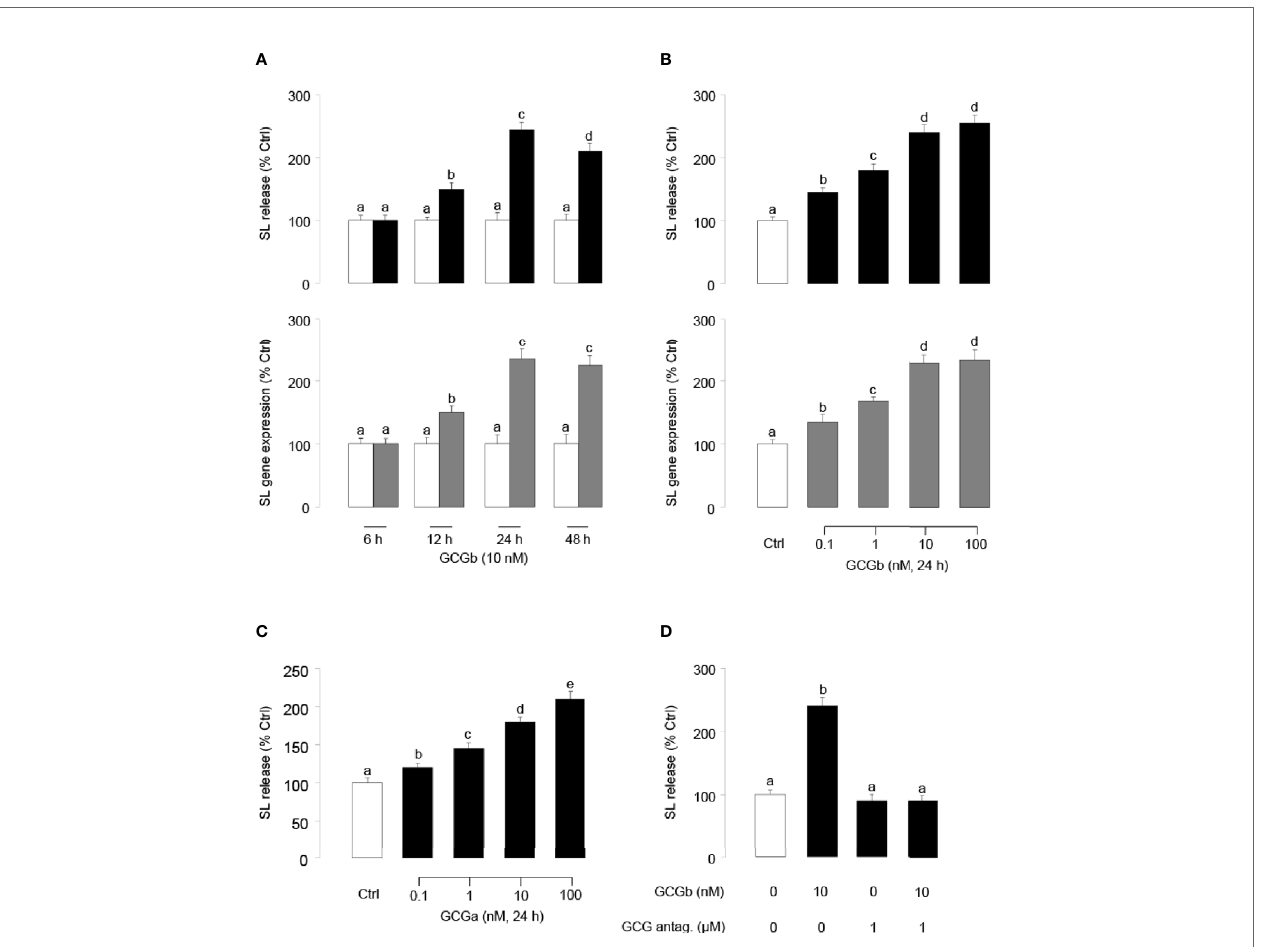
FIGURE 5 | Up-regulation of SL release and gene expression in tilapia NIL cells by GCGs. (A) Time course of tilapia GCGb treatment on SL release (upper panel) and mRNA expression (lower panel) in tilapia NIL cells. In these studies, NIL cells were incubated with GCGb (10 nM) for the duration as indicated. (B) Dose- dependence of GCGb treatment on SL release (upper panel) and mRNA expression (lower panel) in primary cultured tilapia NIL cells. NIL cells were routinely challenged for 24 h with increasing levels of GCGb (0.1 – 100 nM). (C) Parallel experiment using increasing doses of GCGa as the stimulant. NIL cells were routinely challenged for 24 h with increasing levels of GCGa (0.1 – 100 nM). (D) Effects of GCG antagonist on GCGb-stimulated SL release in NIL cells. The NIL cells were incubated for 24 h with GCGb (10 nM) in the presence or absence of GCG antagonist (1 µM). All results are expressed as the mean ± SEM (N = 3) and different superscript letters in each column show signi fi cant differences ( P < 0.05, ANOVA followed by a Bonferroni ’ s ( Figure 7D ), indicating that the effect of GCGb on SL release is PKC-independent.